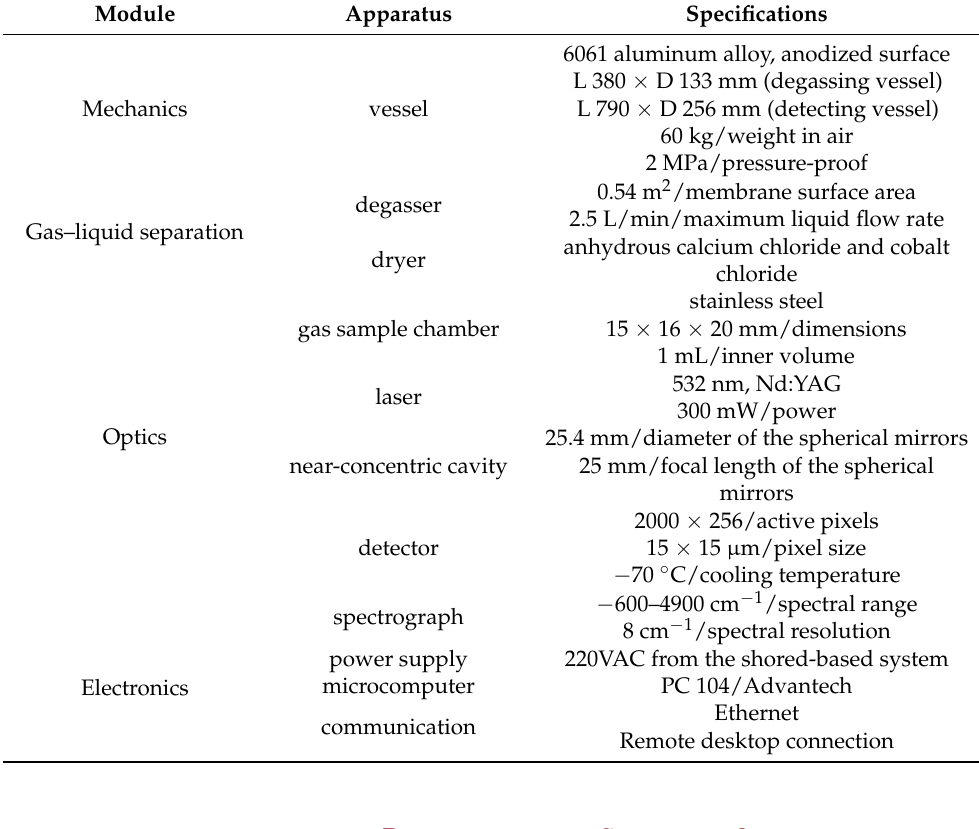
Table 1. Specifications of the in situ underwater Raman system for dissolved gas detection.